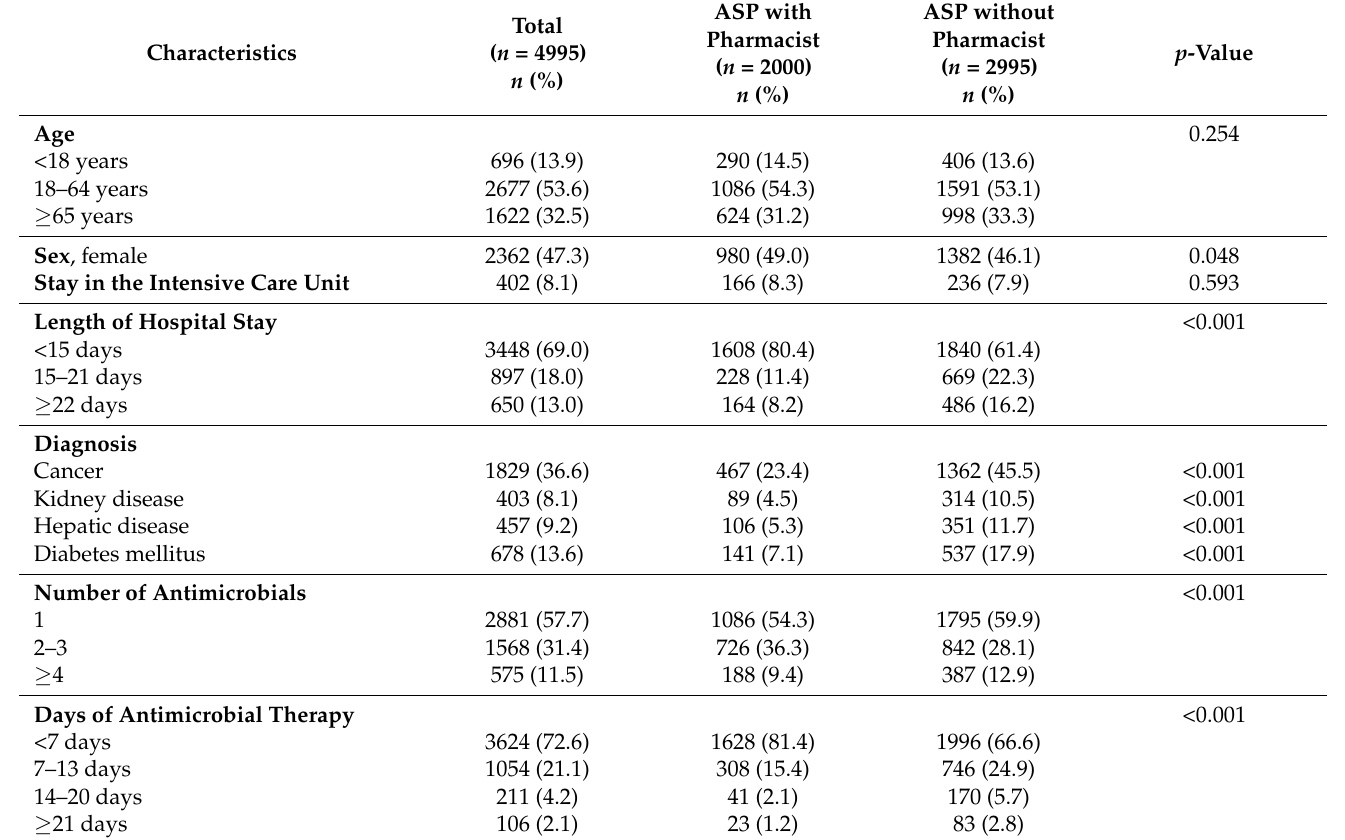
Table 1. Baseline characteristics of the